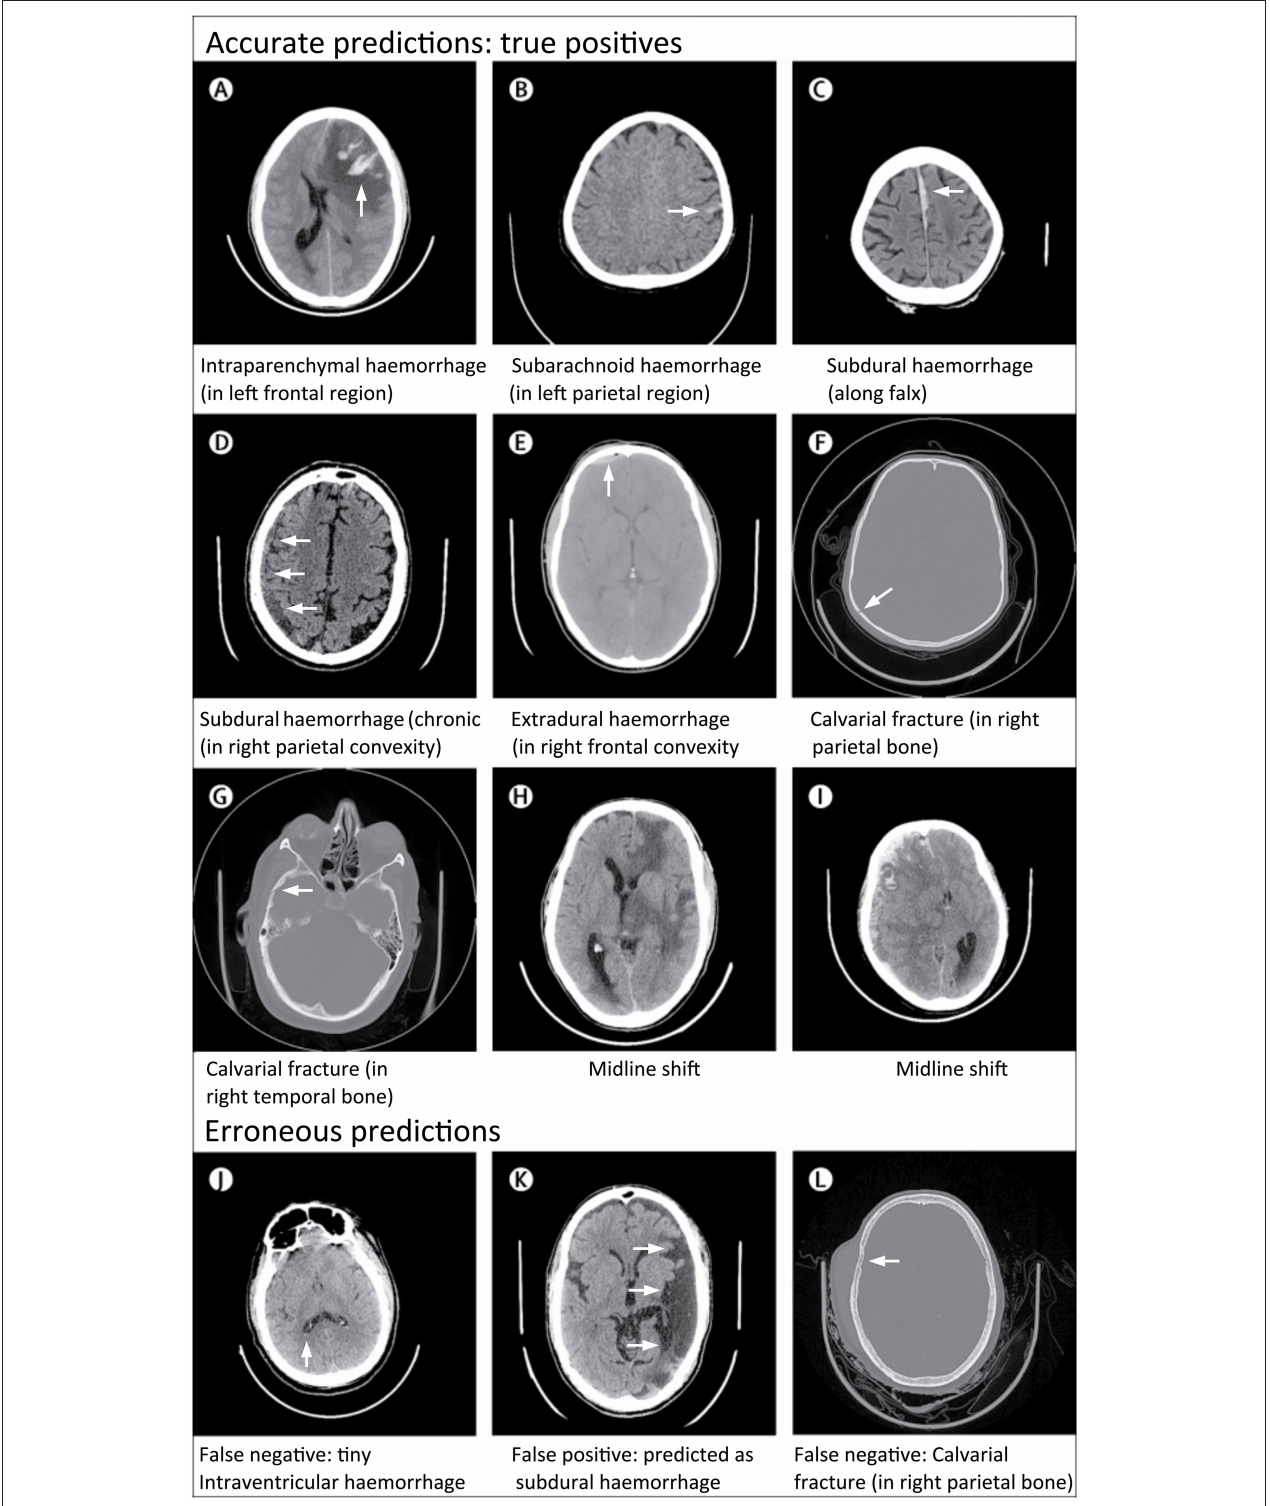
FIGURE 8 | Examples of accurate and erroneous predictions of abnormalities on head CT in acute TBI patients by a deep learning algorithm (26). Although individual images are shown, the model classifies abnormalities at the head CT exam level. All images under Accurate Predictions (A–I) have arrows added to indicate the abnormal lesion. All images under Erroneous Predictions (J–L) have arrows added to indicate the erroneous lesion predictions.